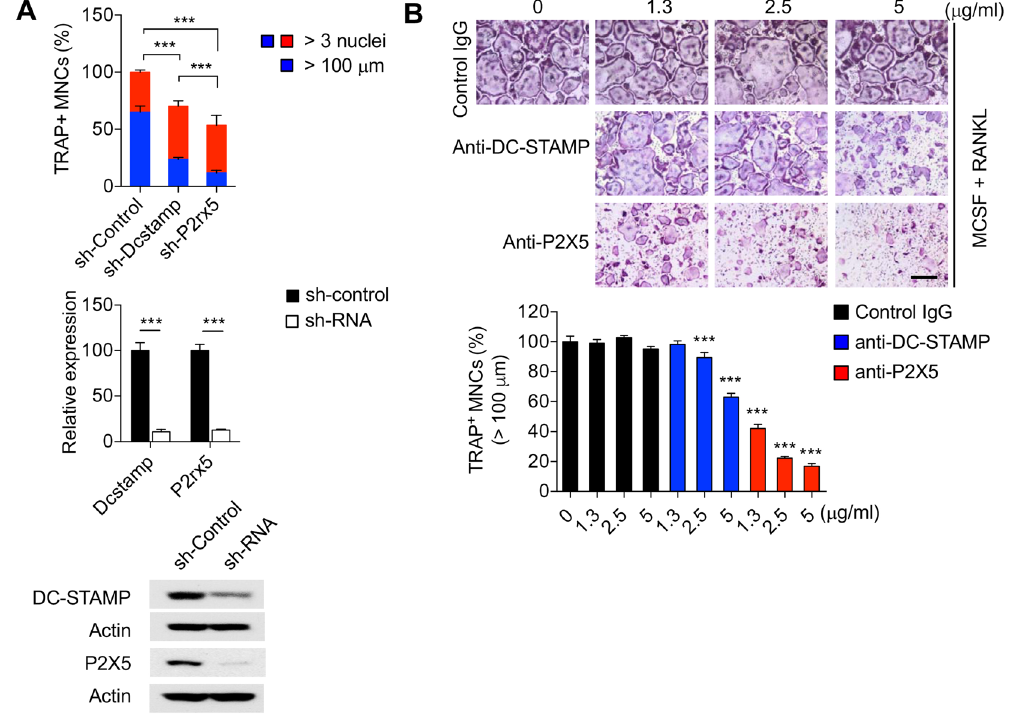
Figure 3. Inhibition of P2X5 suppresses in vitro OC maturation. ( A ) TRAP + MNCs in mature (3 days post- addition of RANKL) OC cultures retrovirally-transduced with control shRNA, or shRNAs against Dcstamp or P2rx5 , upper panel. Relative (to control shRNA-tranduced cells) expression of Dcstamp or P2rx5 in mature OC cultures retrovirally-transduced with control shRNA, or shRNAs against Dcstamp or P2rx5 , as determined by qPCR, middle panel. Western blot analysis of expression of DC-STAMP or P2X5 in mature OC cultures retrovirally-transduced with control shRNA, or shRNAs against Dcstamp or P2rx5 , lower panel. ( B ) OC cultures treated with increasing concentrations of control IgG, inhibitory anti-DC-STAMP, or inhibitory anti-P2X5 polyclonal antibodies. The upper panel shows the effects on day 3 OC cultures and the lower panel shows quantitation of decreases in TRAP + MNCs relative to control IgG treatment. Scale bar represents 100 μ m. *** P < 0.001. Data are shown as means ±